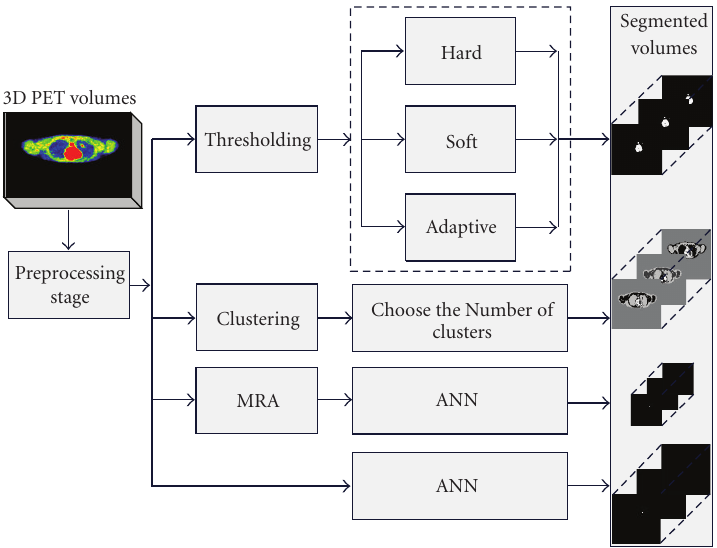
Figure 1: Proposed system for PET volume segmentation.